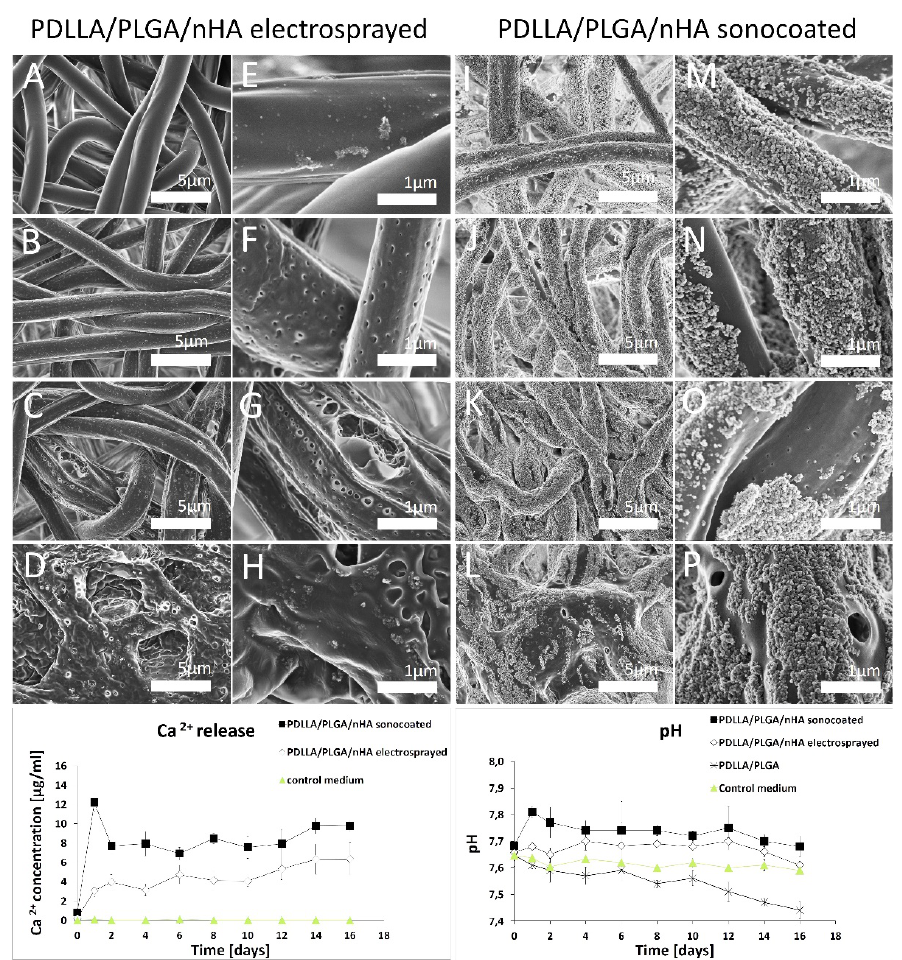
Figure 10. Graphs of ICP-OES calcium release and pH changes profiles, and SEM images of PDLLA/PLGA/nHA Electrosprayed fibers, ( A – H ) PDLLA/PLGA/nHA Sonocoated fibers ( I – P ), after PDLLA / PLGA / nHA Electrosprayed fibers, ( A – H ) PDLLA / PLGA / nHA Sonocoated fibers ( I – P ), after 2,4,8,10 weeks of degradation (from the top down, respectively). 2,4,8,10 weeks of degradation (from the top down,